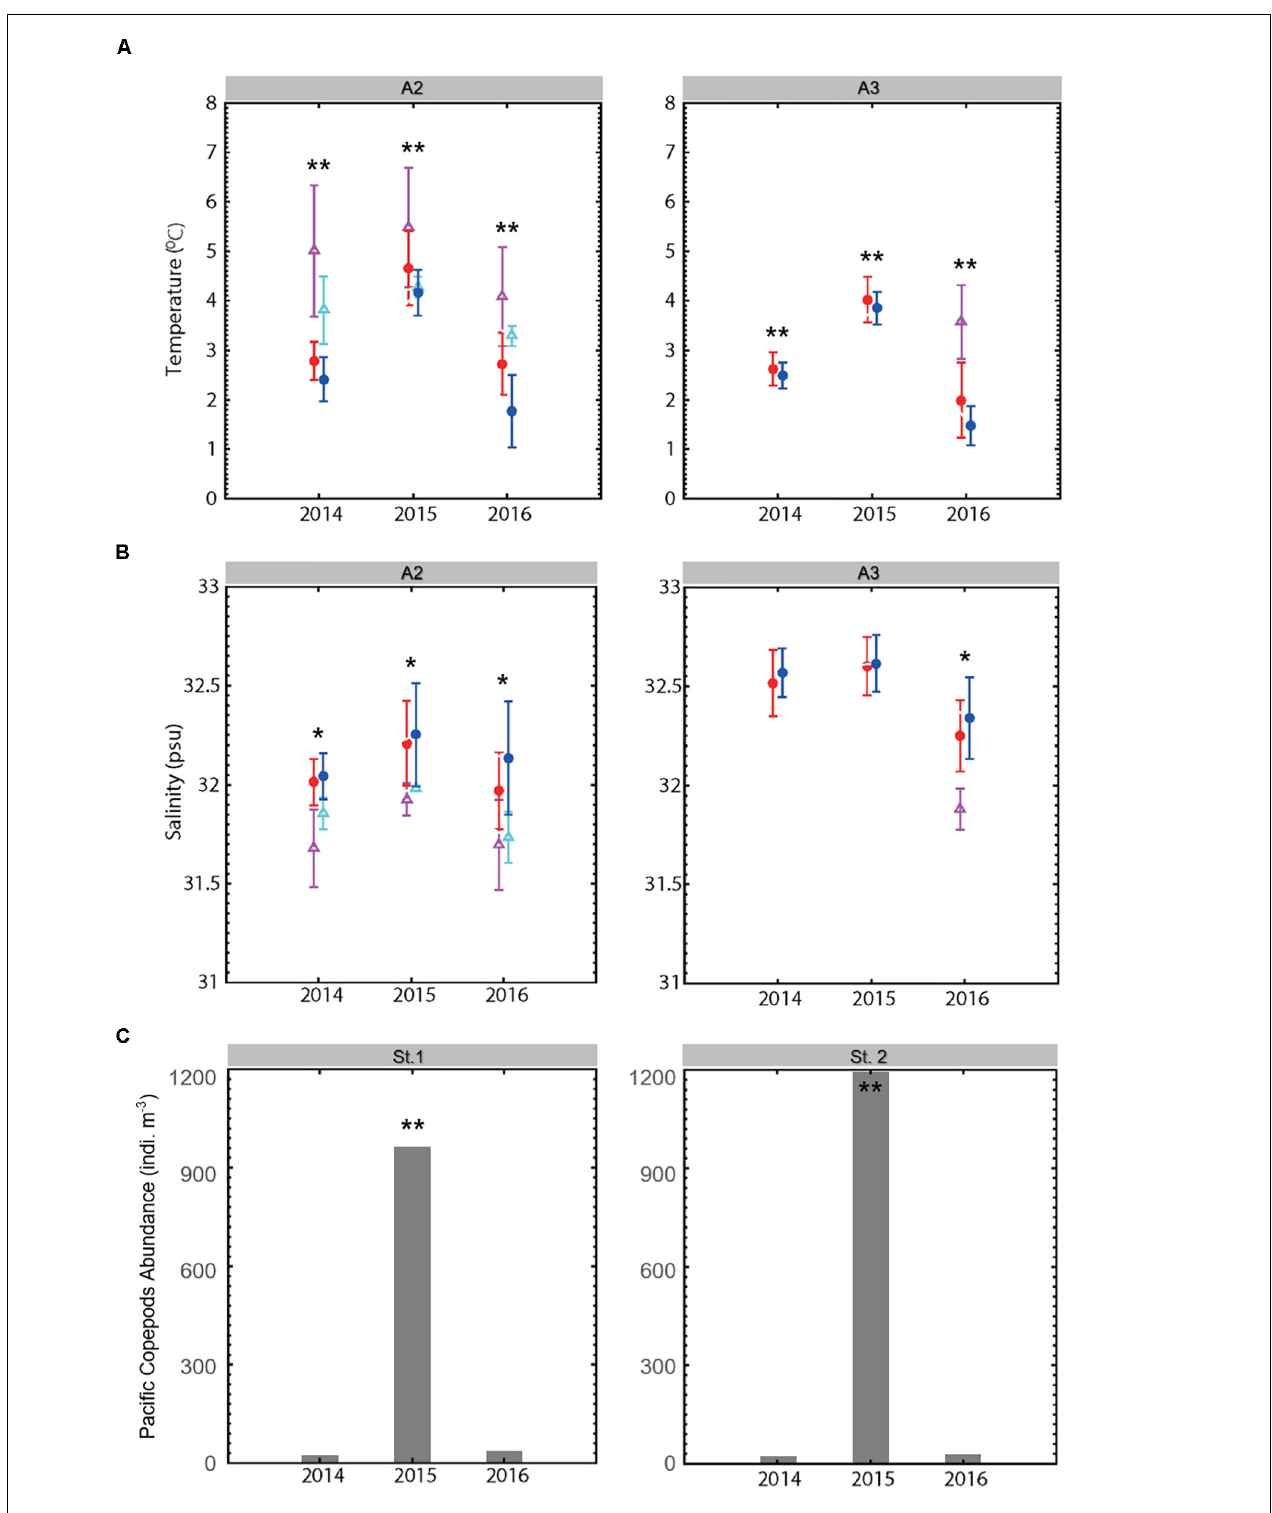
FIGURE 4 | (A) A2 and A3 mooring mean temperature for 20 July – 10. August 2014–2016. Asterisk (*) indicates significant difference (* p < 0.05; ** p < 0.001); (B) A2 and A3 mooring mean salinity for 20 July – 10. August 2014–2016 (Red circles: BSW surface; Blue circles: BSW bottom; mauve triangles: ACW surface; cyan triangles: ACW bottom); (C) St. 1 and St. 2 abundance of Pacific copepods (indiv. m − 3 ).